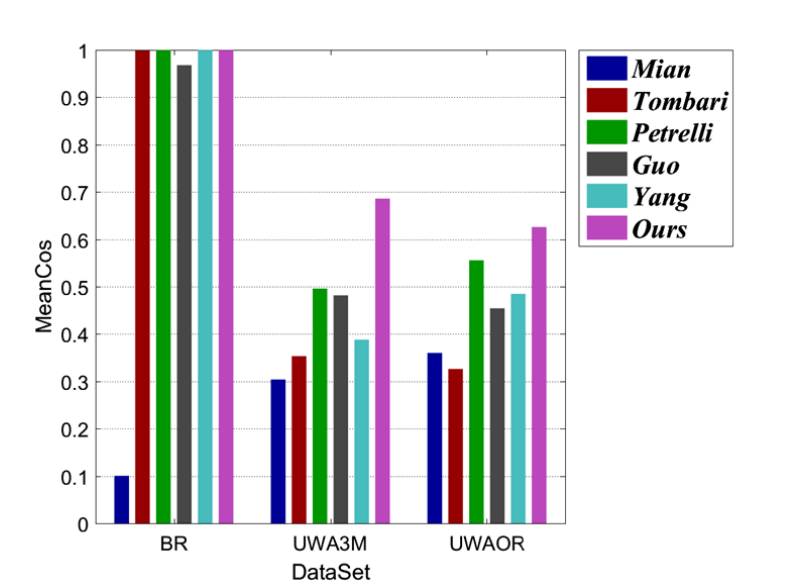
Figure 6. Repeatability performance of six LRF methods on the Bologna retrieval (BR), UWA 3D modeling (UWA3M), and UWA object recognition (UWAOR) datasets.